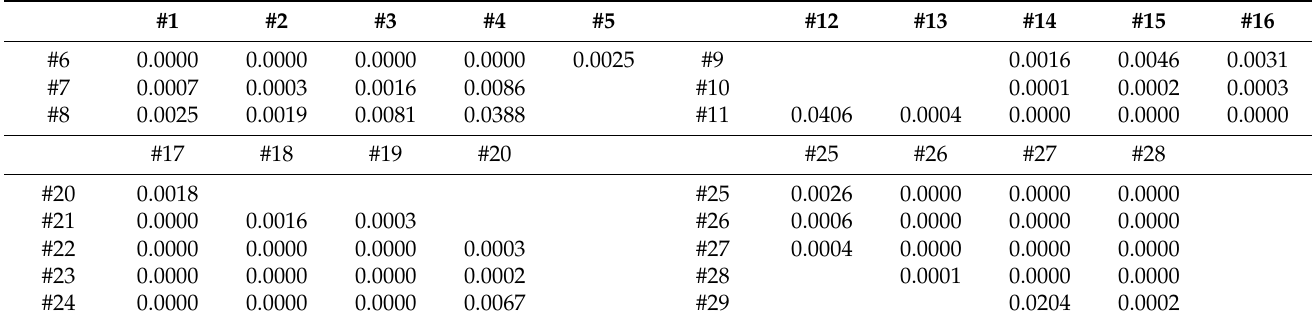
Figure 3. Mean value of the prognosis rank on each tooth type. The specific pattern of diagnosis rank was observed. Table 3. Results of Tukey’s post hoc test. Anterior teeth (#6, 7, 8, 9, 10, 11, 22, 23, 24, 25, 26, and 27) indicated a significantly higher rank than premolars and molars.